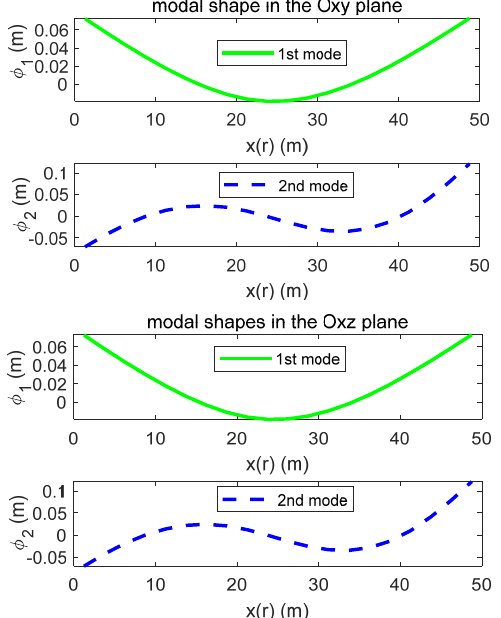
Aerospace 2022 , 9 , x FOR PEER REVIEW Figure 6. Wind speed estimation, in Scenario 1 with wind. Figure 6. Wind speed estimation, in Scenario 1 with wind.